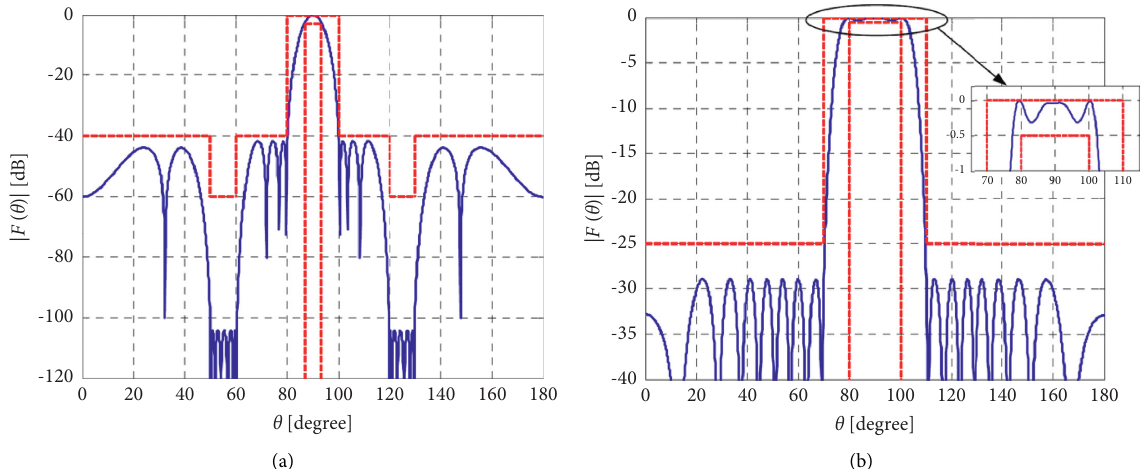
Figure 6: Examples of AF patterns synthesized using a gradient-based optimizer enhanced with analytical derivatives and smart random search [44, 46]: (a) sum pattern; (b) sector-beam